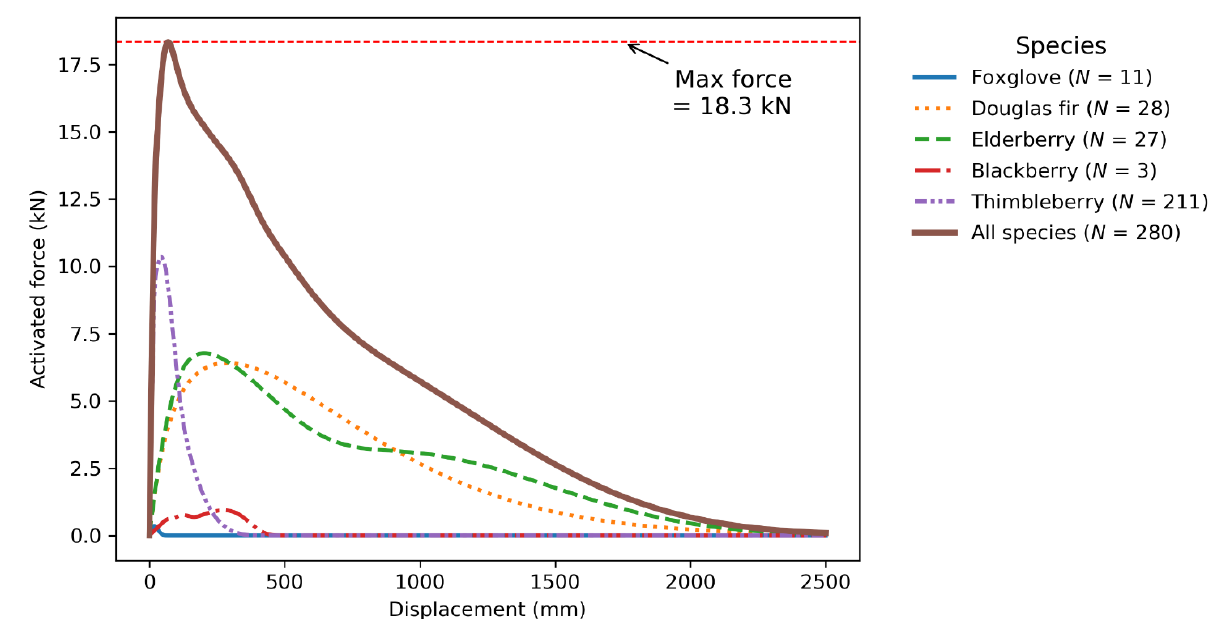
Figure 9. Force-displacement curve resulting from the RBMw model. Horizontal dashed line shows the maximum activated force.